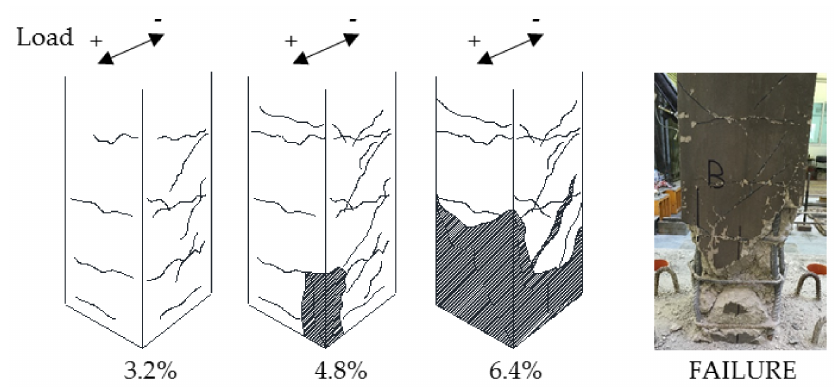
Figure 10. Damage evolution for control column